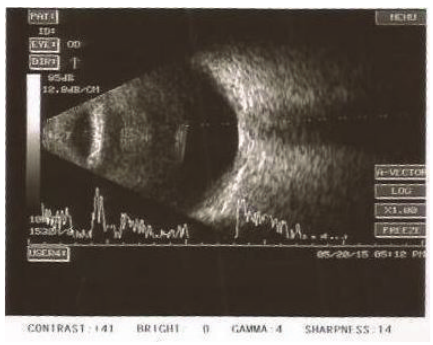
Figure 5: Right eye (Patient 2) B-scan ultrasosonography shows normal features suggesting resolution of choroidal detachment following withdrawal of chlorthalidone.